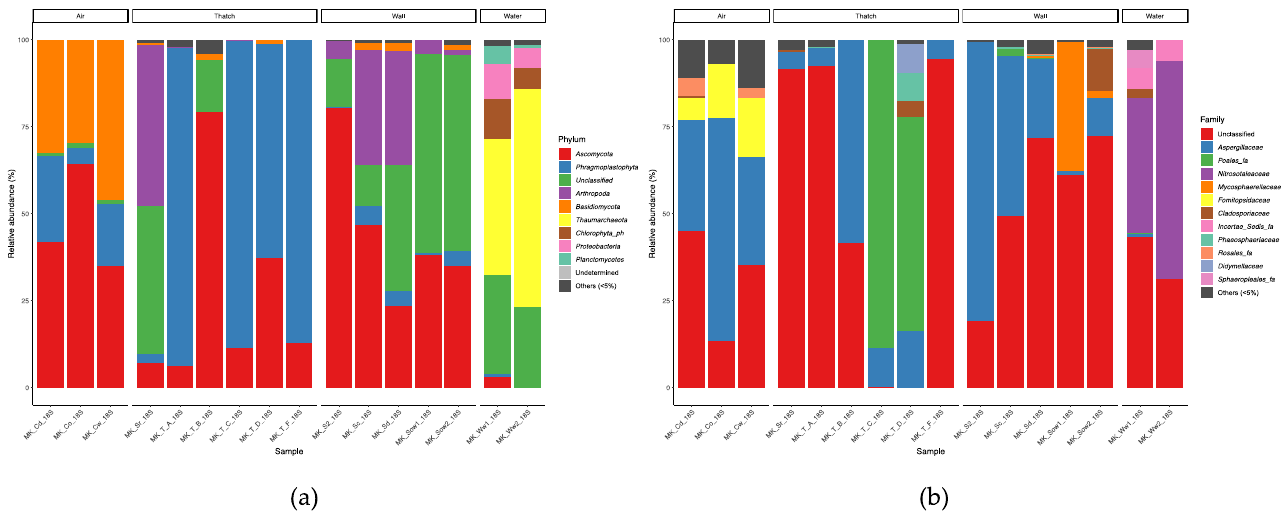
Figure 11. Taxonomic composition of eukaryotes at the phylum ( a ) and family ( b ) levels.